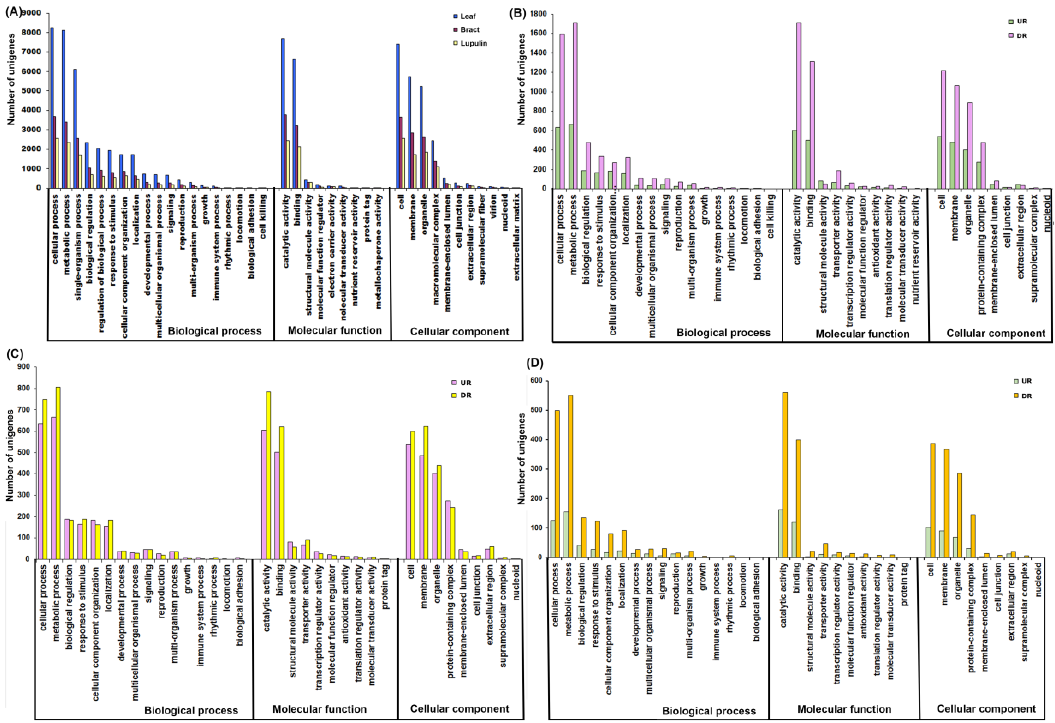
Figure 4. Comparison of Gene Ontology (GO) classifications of combined and tissues-specific unigenes ( A ) differentially expressed genes in bract compared to leaf ( B ), lupulin glands compared to bract ( C ) and lupulin glands compared to leaf ( D ). The results are summarized in three main categories: Biological process, Cellular component, and Molecular function. The x -axis indicates subcategories; right y -axis indicates number of genes in a category. UR: up-regulated, DR: down-regulated.